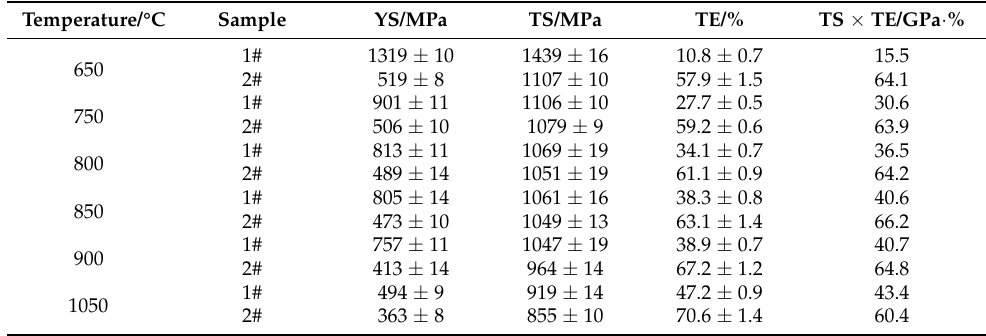
Table 2. Mechanical properties of steel 1# and steel 2# after different solid solution, temperatures for 6 min. (YS: yield strength; TS: tensile strength; TE: total